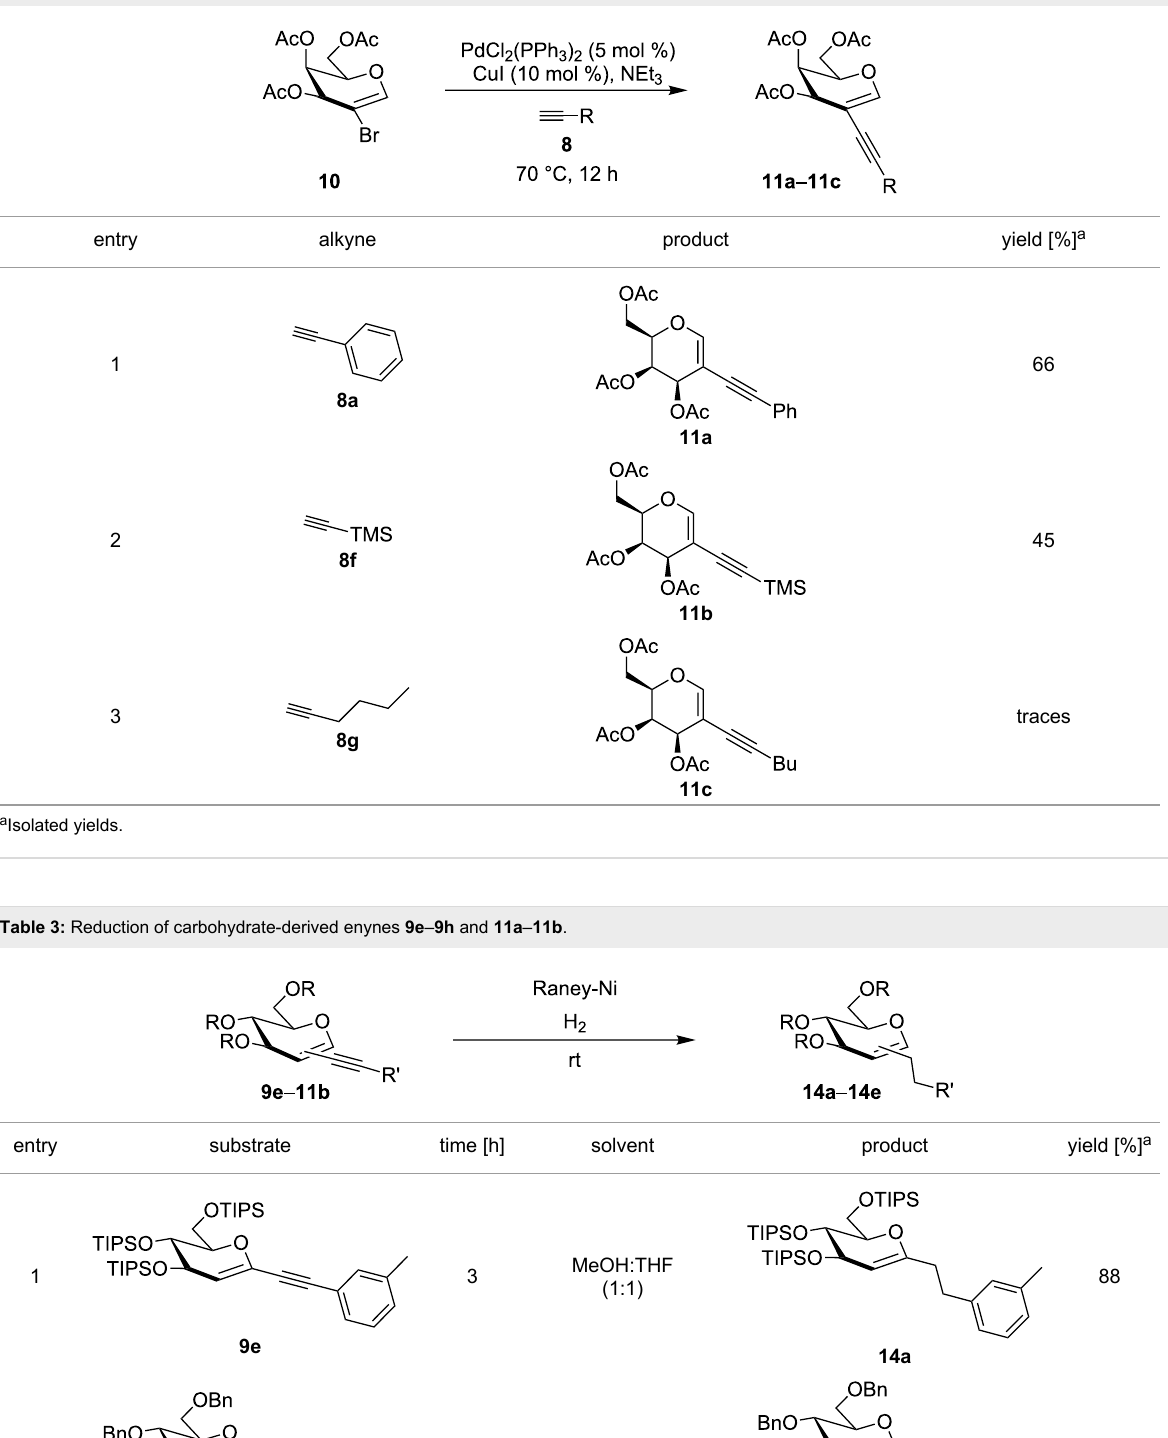
Table 2: Sonogashira–Hagihara reactions of 2-bromogalactal 10 with different alkynes.